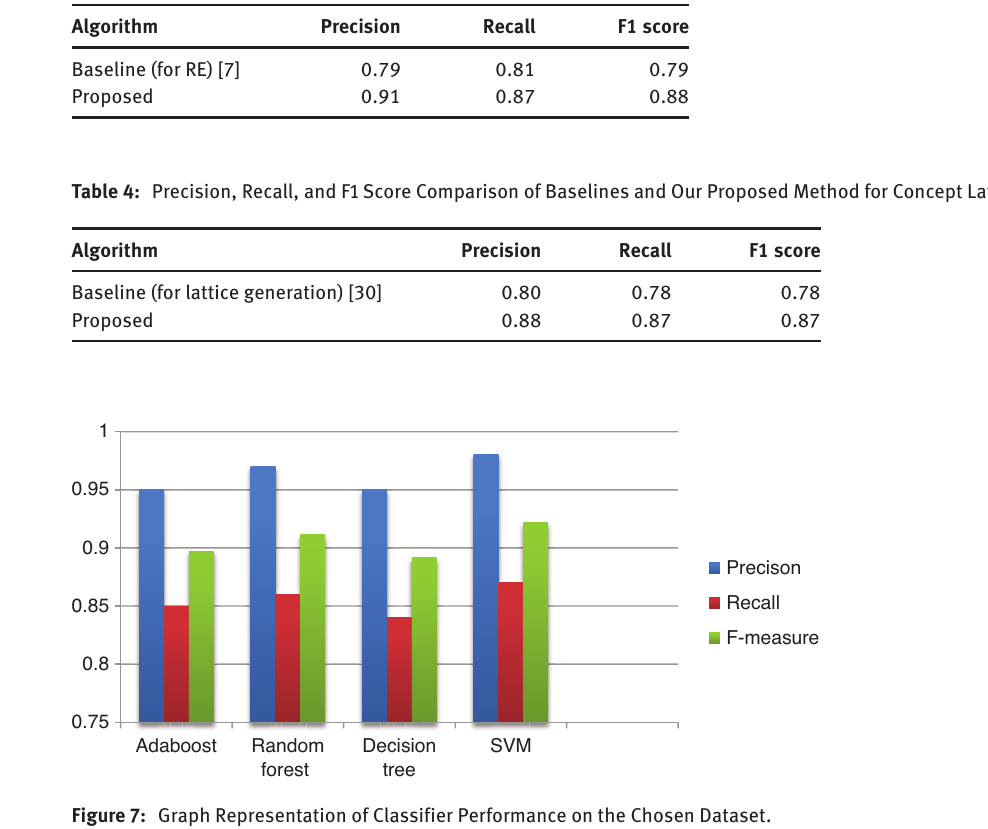
Figure 7: Graph Representation of Classifier Performance on the Chosen